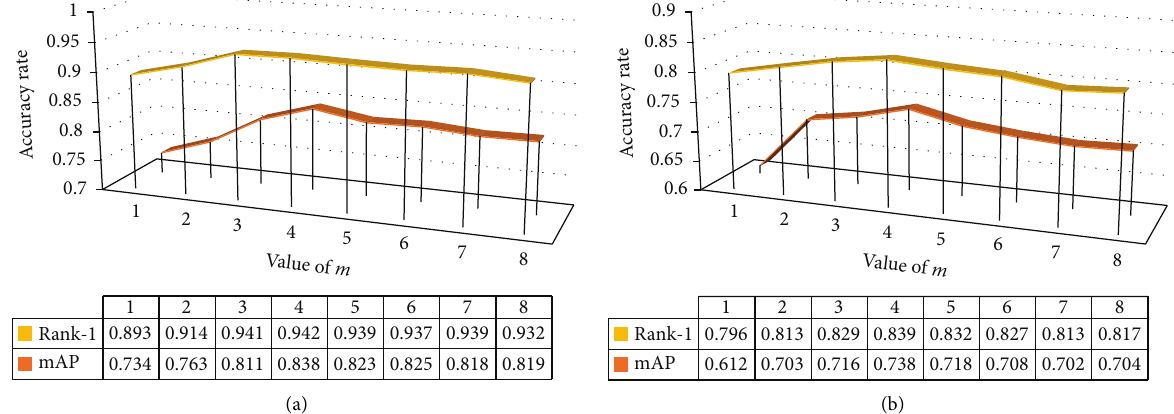
Figure 9: Branch number curve on the two data sets. (a) Branching curve on the DanceDB data set. (b) Branching curve on the FolkDance data set.